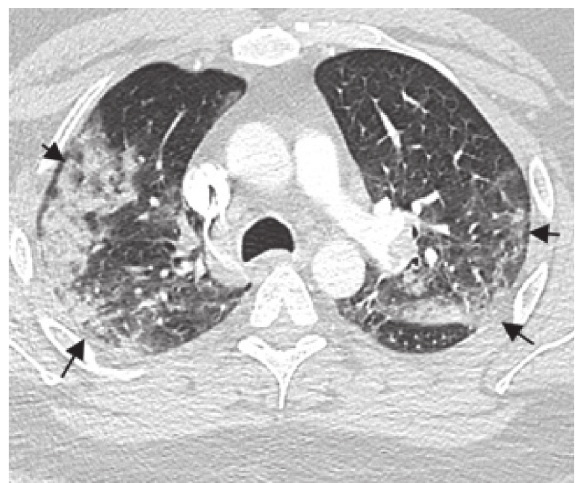
Figure 3: Chest axial CT image on a lung window shows extensive patchy solid and ground-glass opacities scattered throughout the lungs and a small consolidation at the left lower lobe, in keeping with advanced multifocal pneumonia (black